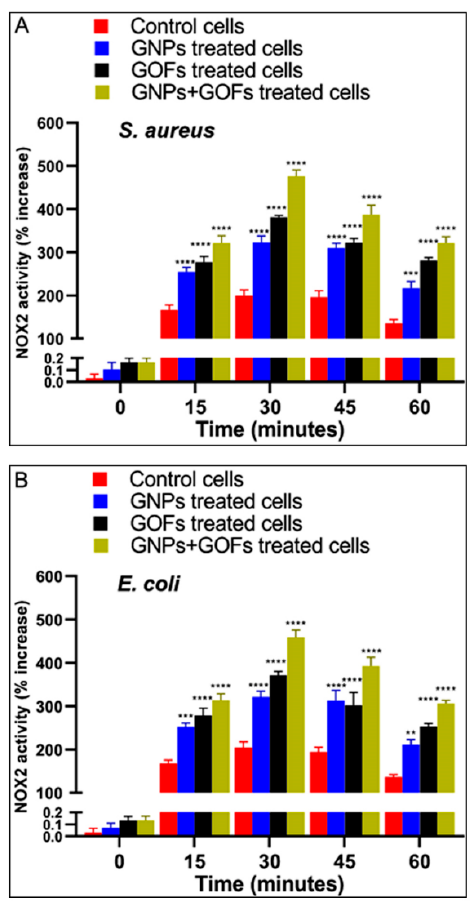
Figure 8. GNPs and GOFs improved NADPH oxidase 2 (NOX2) activity in BMDMs infected with Staphylococcus aureus or Escherichia coli in the presence and absence of GNPs and GOFs. NOX2 activity in BMDMs was assessed kinetically with lucigenin. Data are shown as mean ± SE at the indicated time. Statistical significance by two-way ANOVA ( p < 0.0001) followed by posthoc testing using Tukey’s multi group comparison with control cells: *** p = 0.0001, **** p < 0.0001 indicate statistically different for ( A ) S. aureus while ** p = 0.002, *** p = 0.0004, **** p < 0.0001 indicate statistically different for ( B ) E. coli.